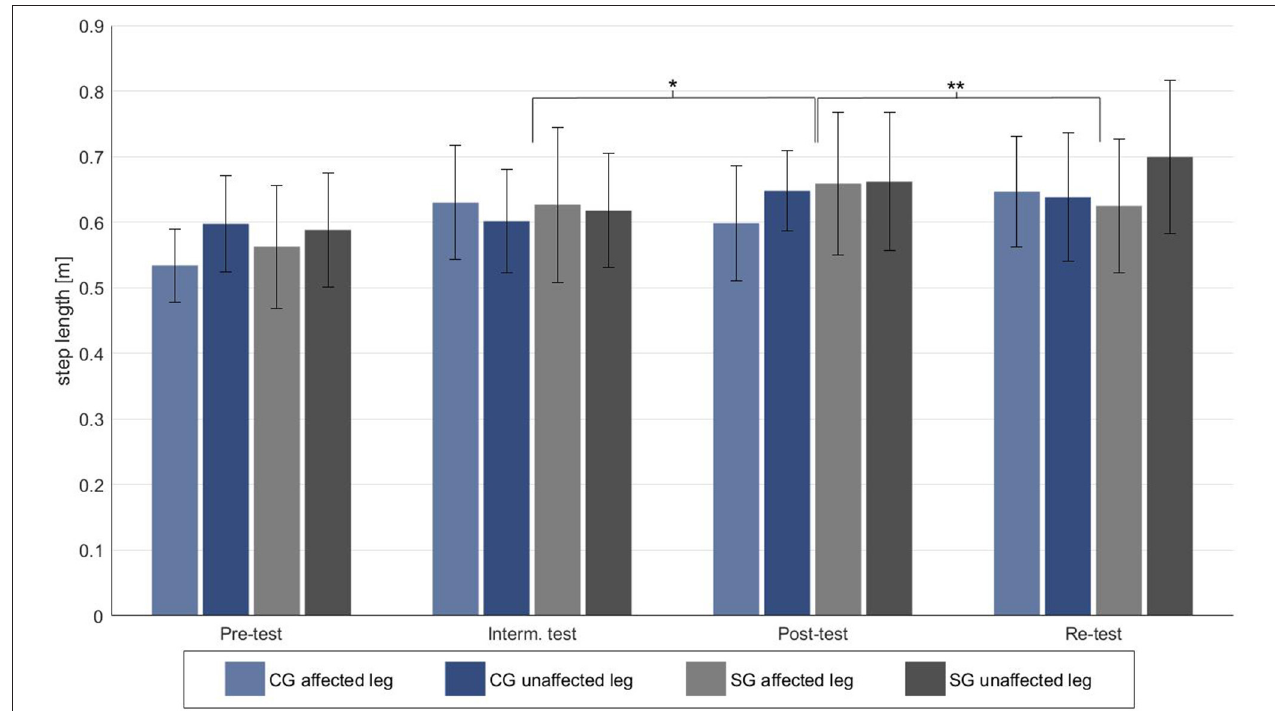
FIGURE 4 | Step length of the affected and unaffected leg for the four test dates. Significant differences are marked with a * p < 0.05 and with a ** p <